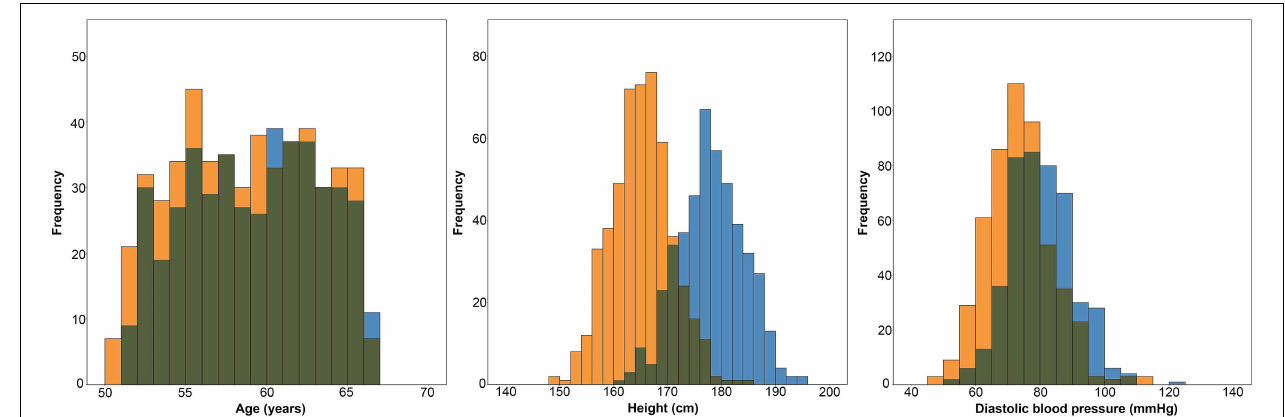
FIGURE 3 | Histograms showing the distributions of age, height and diastolic blood pressure in women (orange) and men (blue).